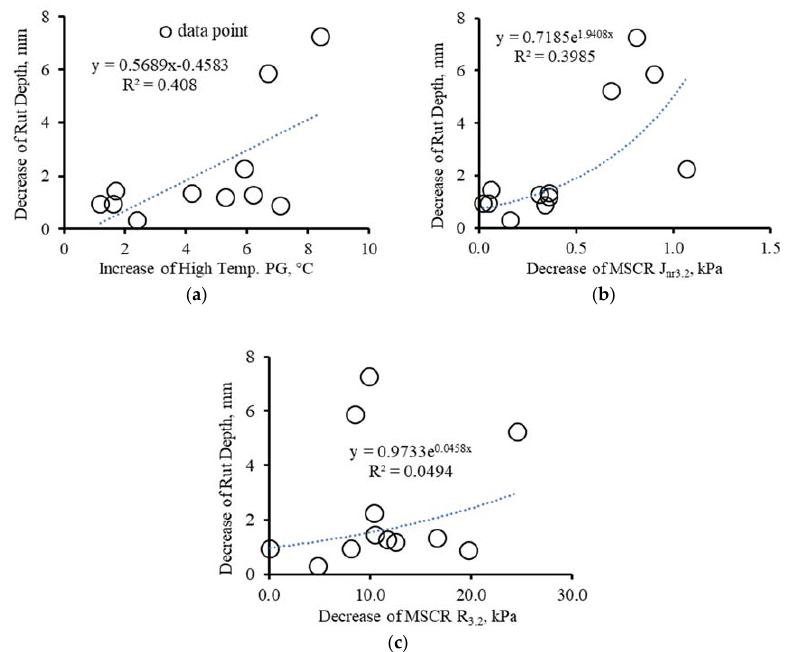
Figure 9. Effect of asphalt binder property change on HWT rut depth change ( a ) increase in high- temperature PG, ( b ) decrease in MSCR Jnr3.2 , and ( c ) increase in MSCR R3.2